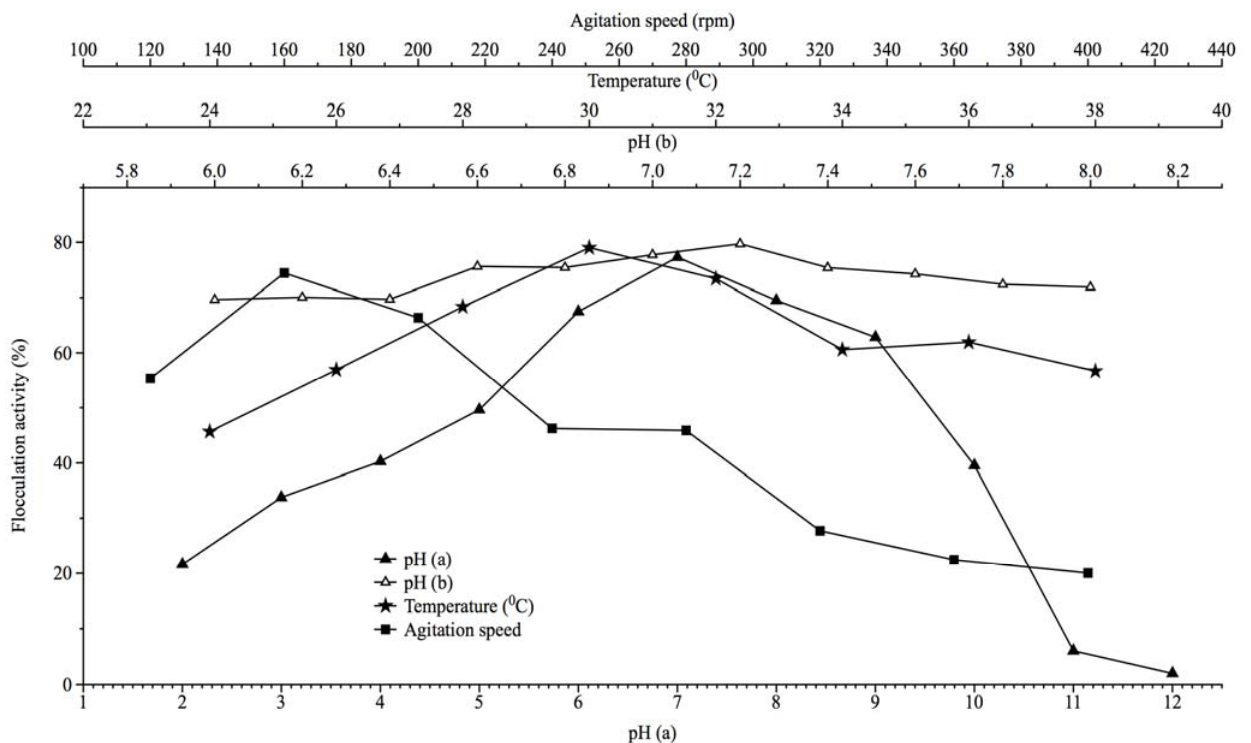
Figure 2. The effects of initial fermentation pH, incubation temperature and agitation speed on bioflocculant production by Brachybacterium sp.